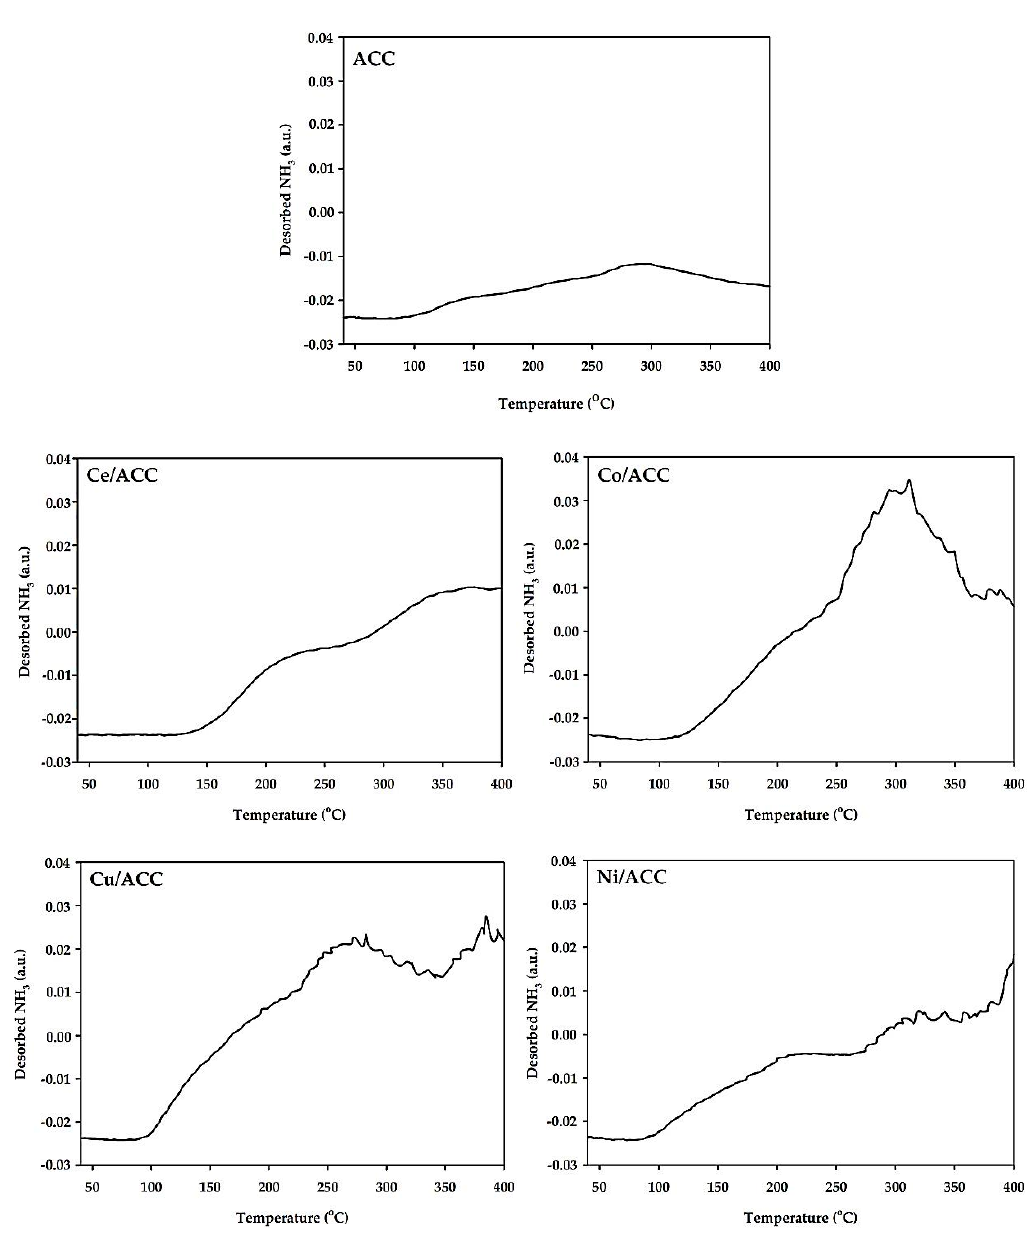
Figure 3. NH 3 -TPD profiles of catalysts.